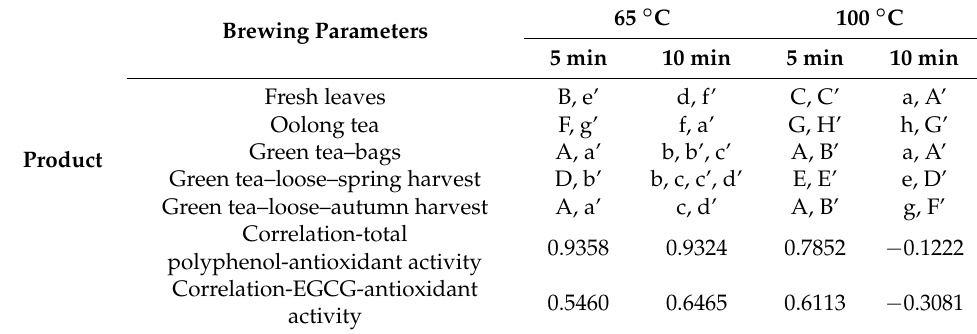
Table 3. Statistical analysis of the influence of brewing parameters on the antiradical activity.